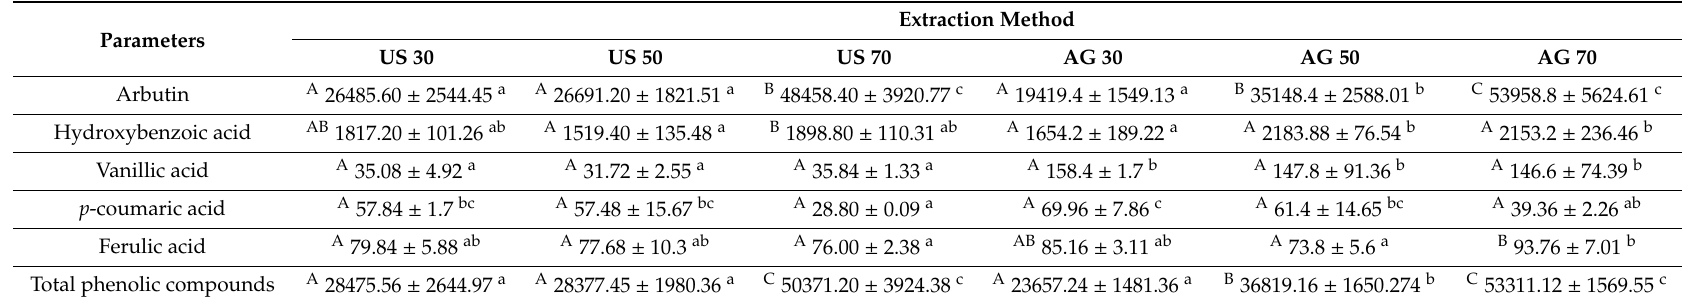
Table 1. E ff ects of ultra-sonication and agitation on phenolic compounds( µ g / g) of amaranth